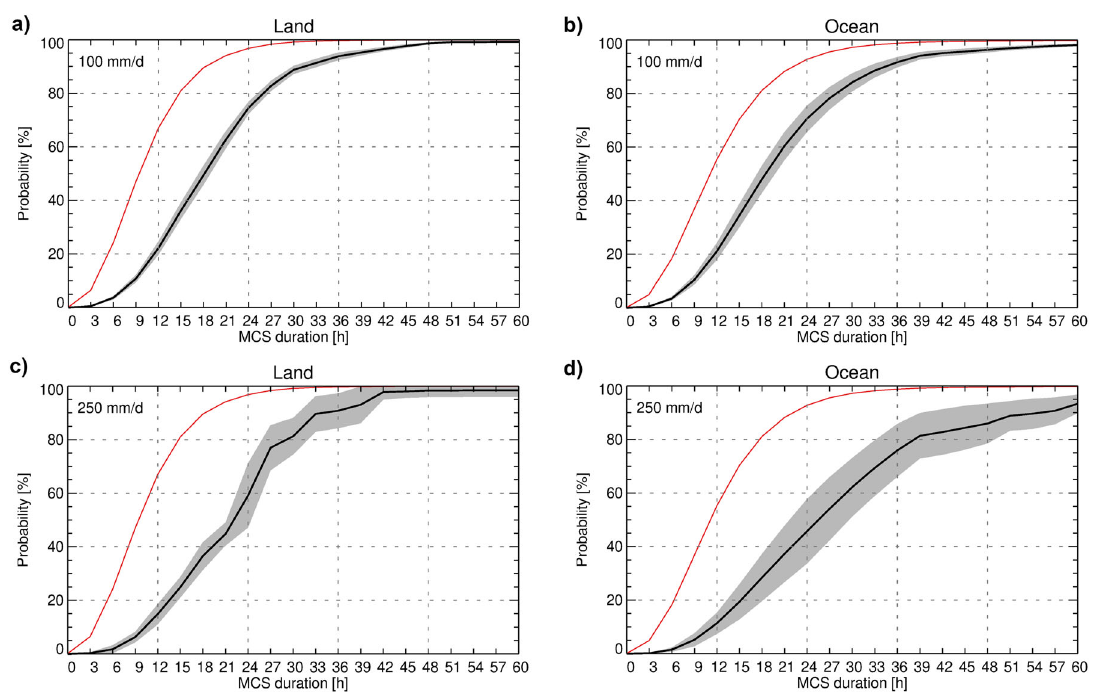
Fig. 2 The joint precipitation-MCS distribution reveals the role of the long-lived systems to the extreme precipitation. The ensemble mean probability of precipitation occurrence exceeding a threshold as a function of MCS duration. The gray shading corresponds to ± one standard deviation of the precipitation products ensemble. The red curve is the cumulated distribution function of the MCS occurrence for all precipitation above 0 mm/d. a For a threshold of 100 mm/d over land and ( b ) of 100 mm/d over ocean ( c ) of 250 mm/d over land and ( d ) of 250 mm/d over